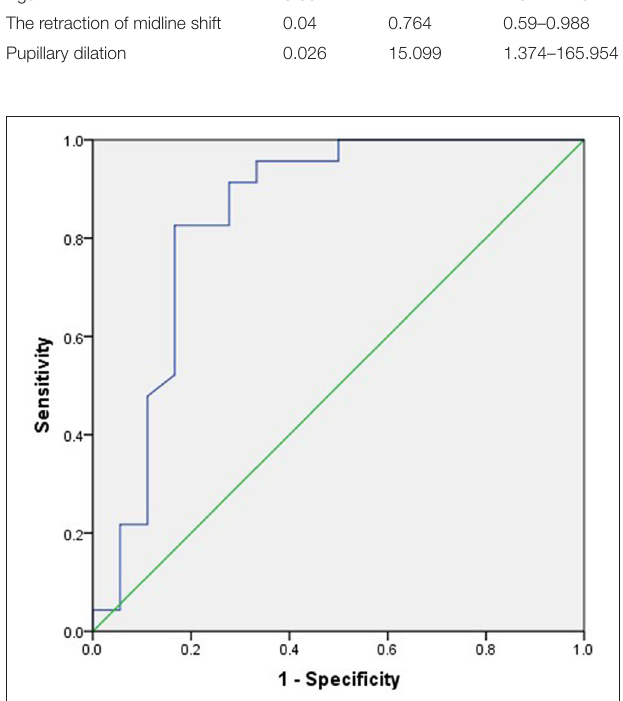
FIGURE 3 | The receiver operating characteristic (ROC) analysis of the relationship between 6-month outcome and midline shift improvement. The area under the curve (AUC) was 0.844, and the cutoff point of midline shift retraction was 0.83cm.